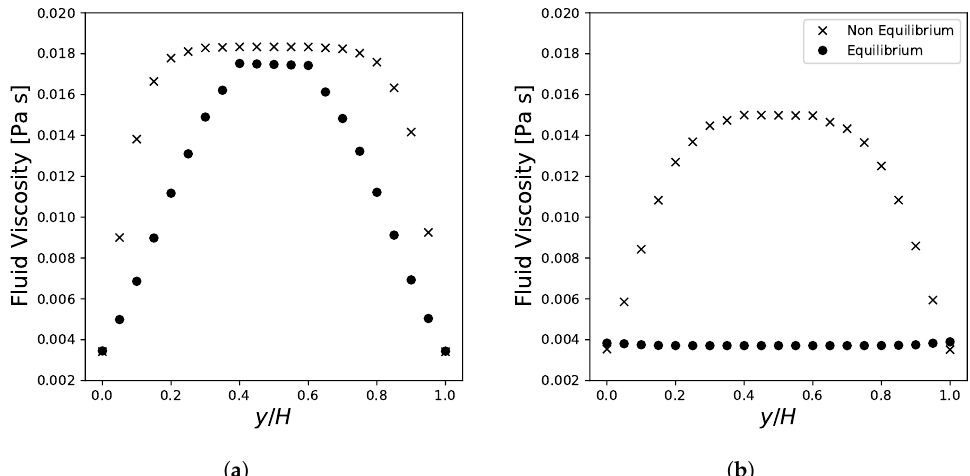
Figure 5. Fluid viscosity development during infiltration for the thermal non-equilibrium and thermal equilibrium model at a location of ( a ) 25% and ( b ) 75% in the domain. Note that the legend in ( b ) is applicable to both